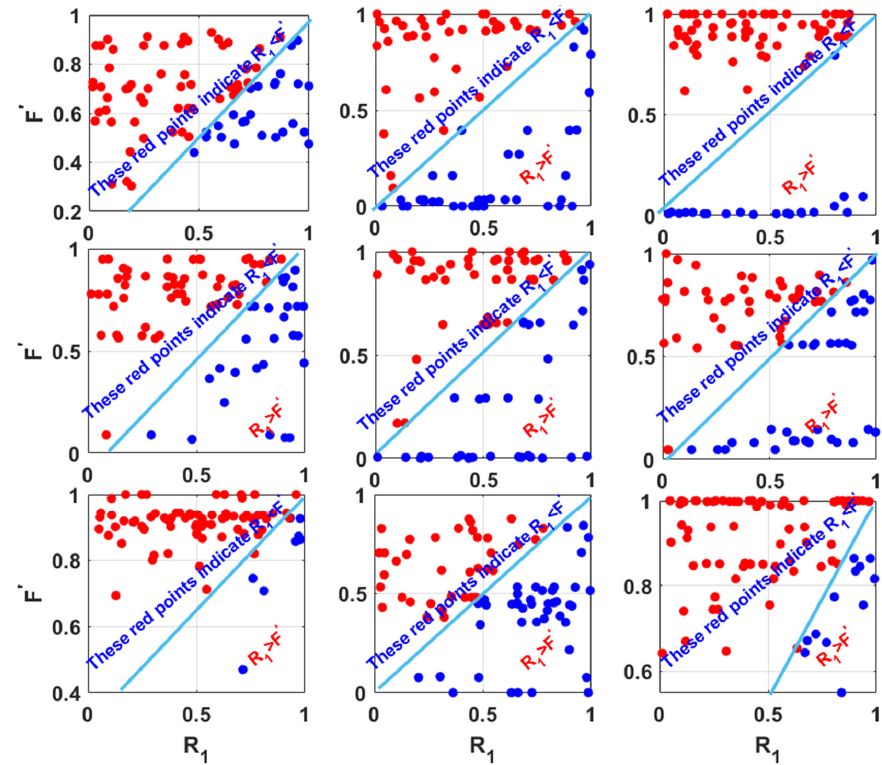
Figure 5. Tracing F’s values versus R 1 for an individual over 9 independent runs: The red points indicate that R 1 < F (cid:48) ; and the blue points indicate that R 1 > F (cid:48)